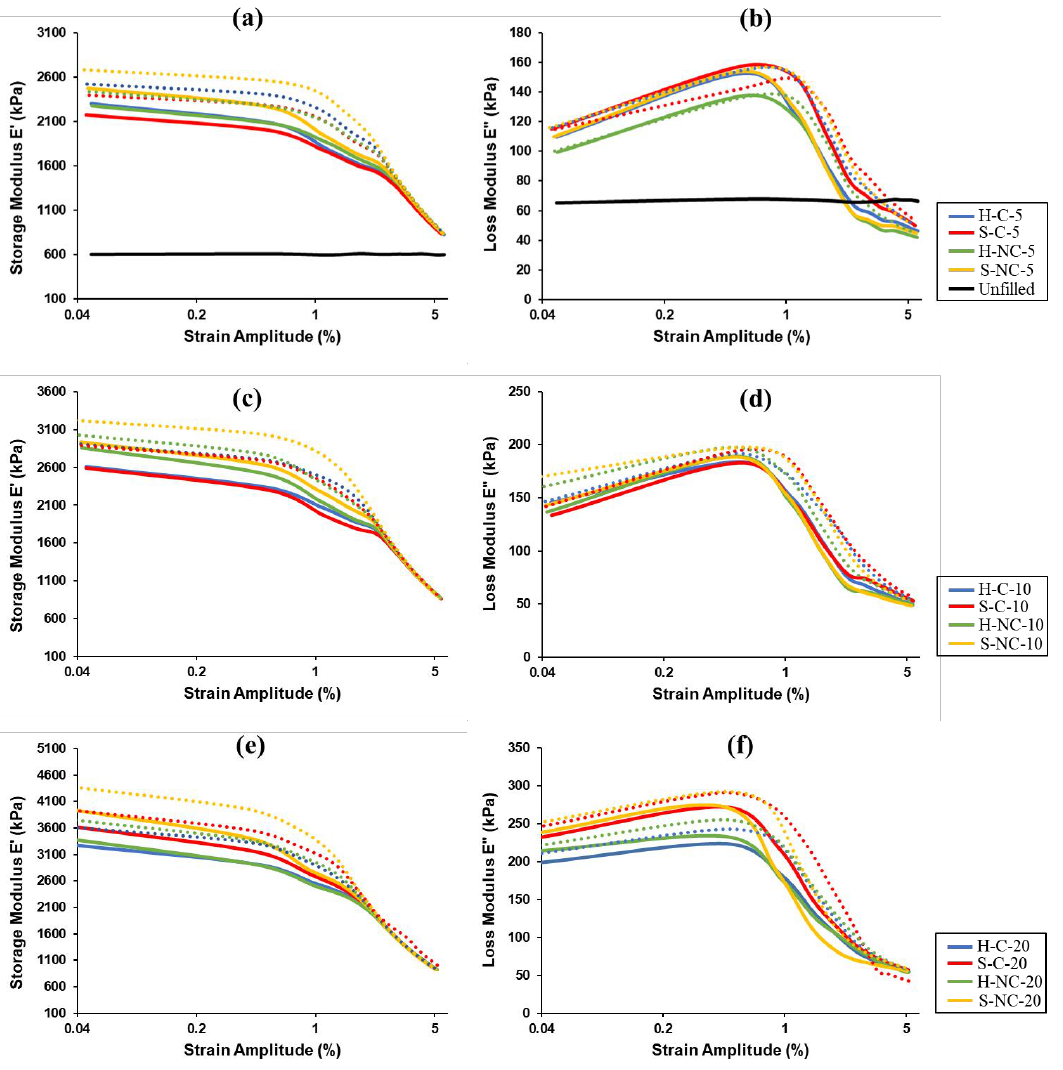
Figure 9. Strain dependence of storage E’ and loss E’’ modulus measured in the off-state (solid lines) and on-state (dotted lines); ( a , b ): at 5%; ( c , d ) at 10%; ( e , f ) at 20% volume fractions.